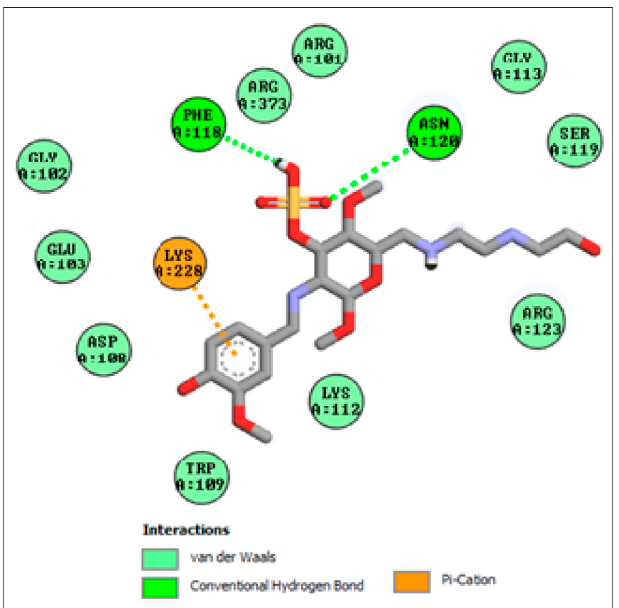
FIGURE 13 | Interaction of compound 2i in the binding pocket of 1Z11 receptor.